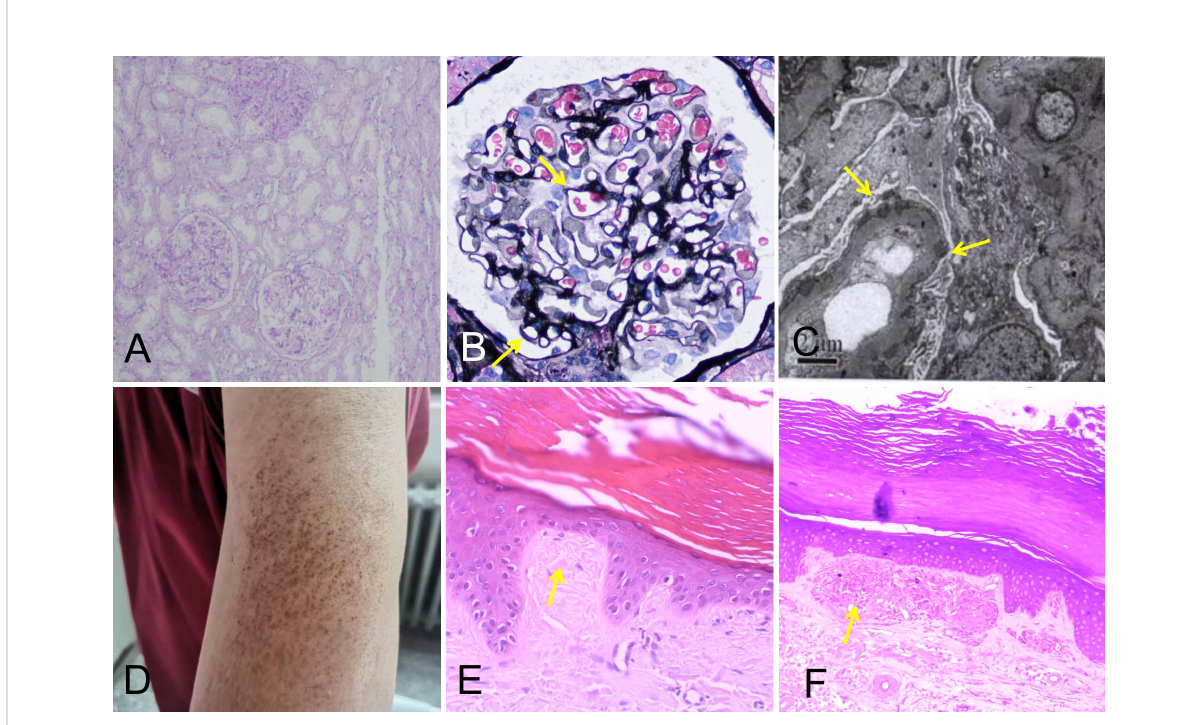
FIGURE 1 Kidney biopsy fi ndings showing stage I membranous nephropathy (A – C) . (A) Normal mesangial cellularity (periodic acid – Schiff; original magni fi cation, ×100). (B) Slight global glomerular basement membrane thickening (yellow arrows; Jones methenamine silver; original magni fi cation, ×400). (C) Subepithelial electron-dense deposits, partially in the glomerular basement membrane (yellow arrows; original magni fi cation, ×4,000). (D) Skin lesions on the patient ’ s left upper arm. (E, F) Skin biopsy fi ndings showing cutaneous amyloidosis. (E) The skin specimen stained by hematoxylin – eosin revealed parakeratosis with focal hyperkeratosis, widened dermal papilla, and an amorphous red- stained mass substance (yellow arrow; ×400). (F) The skin specimen stained by crystal violet was positive (yellow arrow;